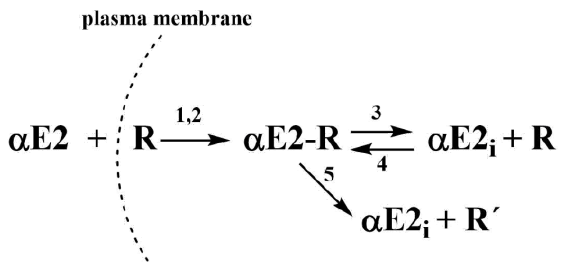
Figure 3. Kinetic scheme where αE2 is the extracellular hormone; R is the active sperm receptor; αE2-R is the adduct; αE2 i is the internal free hormone and R’ is the inactive sperm receptor. 1 and 2 represent the rate constants of the simultaneous non-autocatalytic and autocatalytic formation of the adduct αE2-R, 3 and 5 represent the rate constants of the adduct decomposition and 4 represents the rate constant of the reverse reaction (taken from [7]).